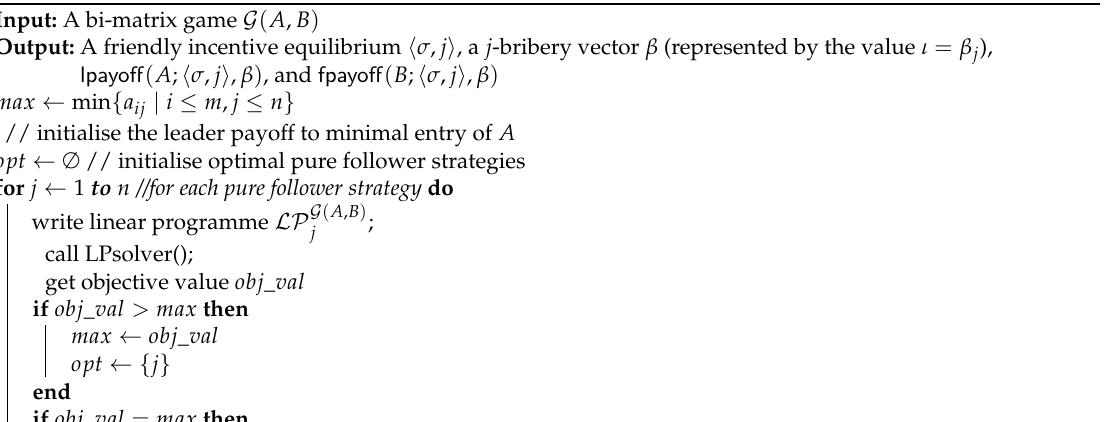
Algorithm 1: The Algorithm outputs a (pure) friendly incentive equilibrium ( (cid:104) σ , j (cid:105) , β ) , a j -bribery vector β , leader payoff lpayoff ( A ; (cid:104) σ , j (cid:105) , β ) and follower payoff fpayoff ( B ; (cid:104) σ , j (cid:105) , β